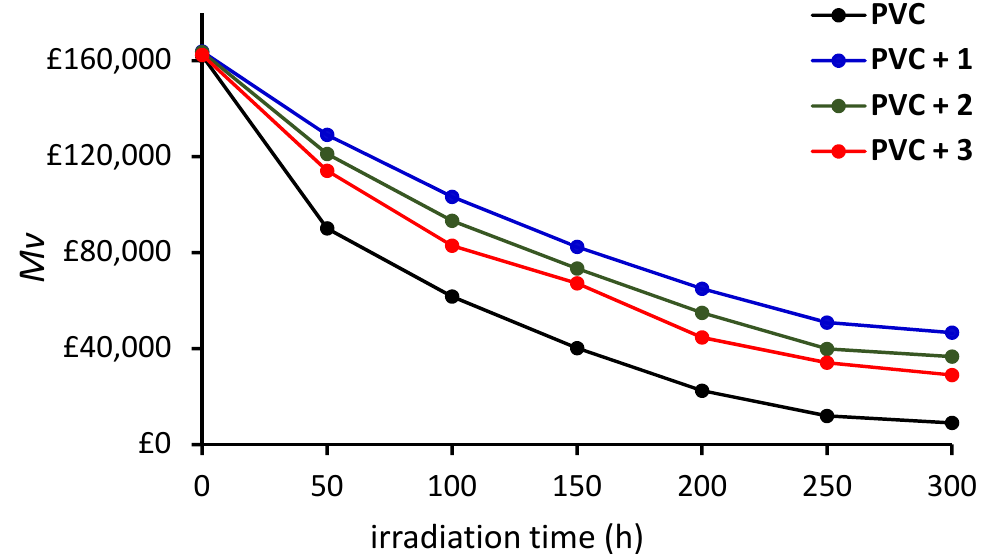
Figure 5. Changes in the M V for PVC films during irradiation.